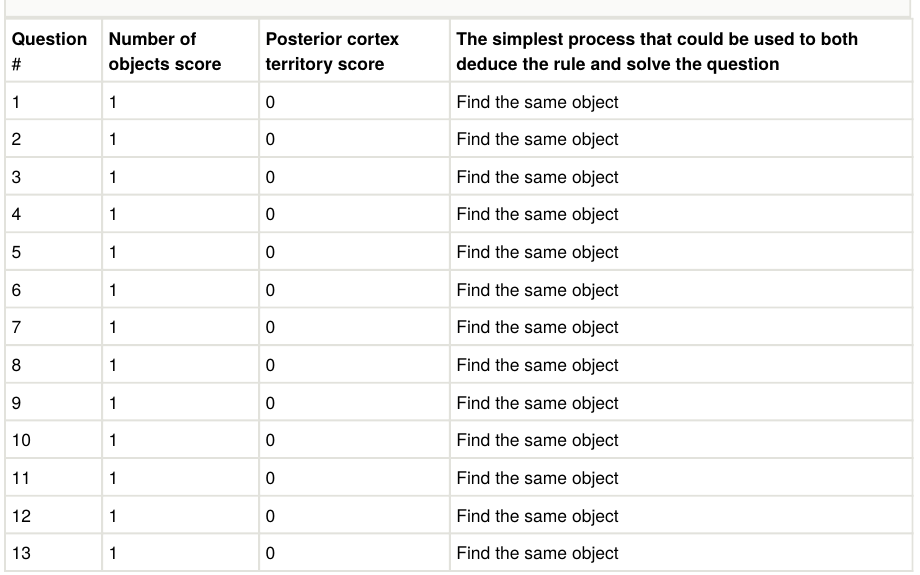
Table 3 similarly lists the processes for Form B of TONI-4. Again, both the NOB score and the PCT score increase from easier questions found at the beginning of the test to the more di ffi cult questions found towards the end (Fig. 8). Table 3. Panel classi fi cation for TONI-4, Form